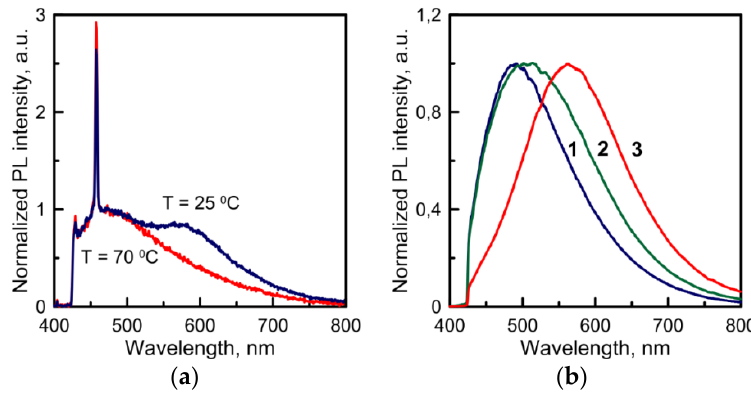
Figure 2. ( a ) Normalized PL spectra of Cd(C 12 H 25 S) 2 powder measured at 25 and 70 °C. ( b ) The evolution of normalized PL spectra of Cd(C 12 H 25 S) 2 powder annealed at 240 °C: 1–5 min, 2–40 min, 3–60 min, measured at room temperature.